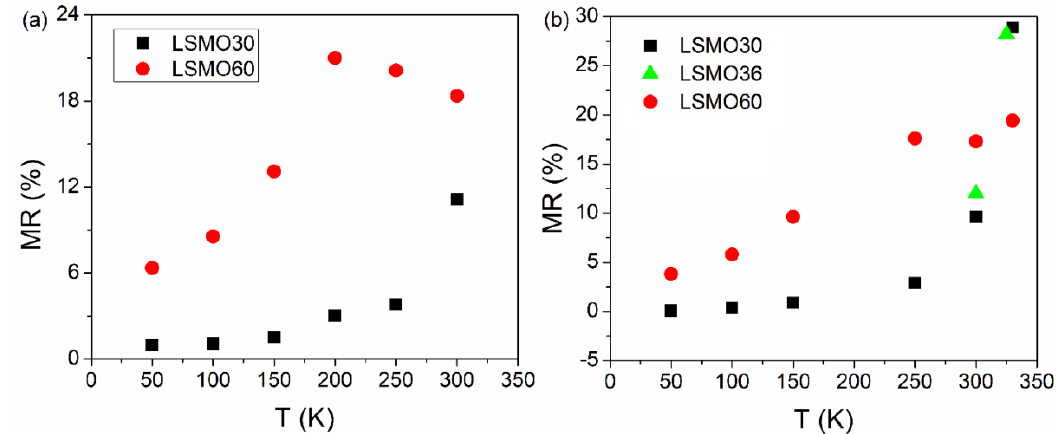
Figure 10. MR effect at different temperatures in parallel ( a ) and perpendicular ( b ) geometry for LSMO 30 and LSMO 60.